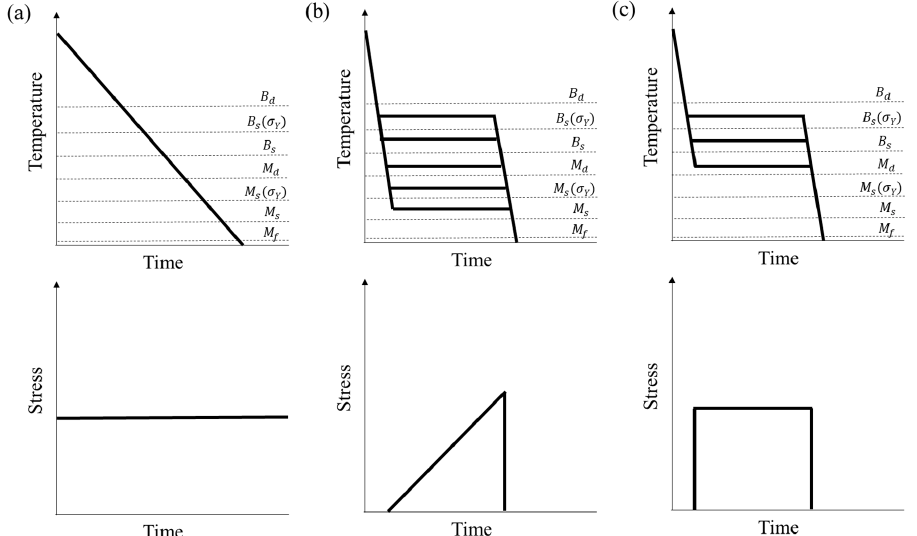
Figure 4. Diagrams showing the possible scenarios to obtain stress induced martensite or bainitic ferrite, where ( a ) repre ‐ sents a continuous cooling under a constant load; ( b ) represents a treatment where a deformation is applied at a fixed ferrite, where ( a ) represents a continuous cooling under a constant load; ( b ) represents a treatment temperature and ( c ) represents a pure isothermal treatment under a constant load. The dashed lines show critical temper ‐ where a deformation is applied at a fixed temperature and ( c ) represents a pure isothermal treatment atures. Units are arbitrary. under a constant load. The dashed lines show critical temperatures. Units are